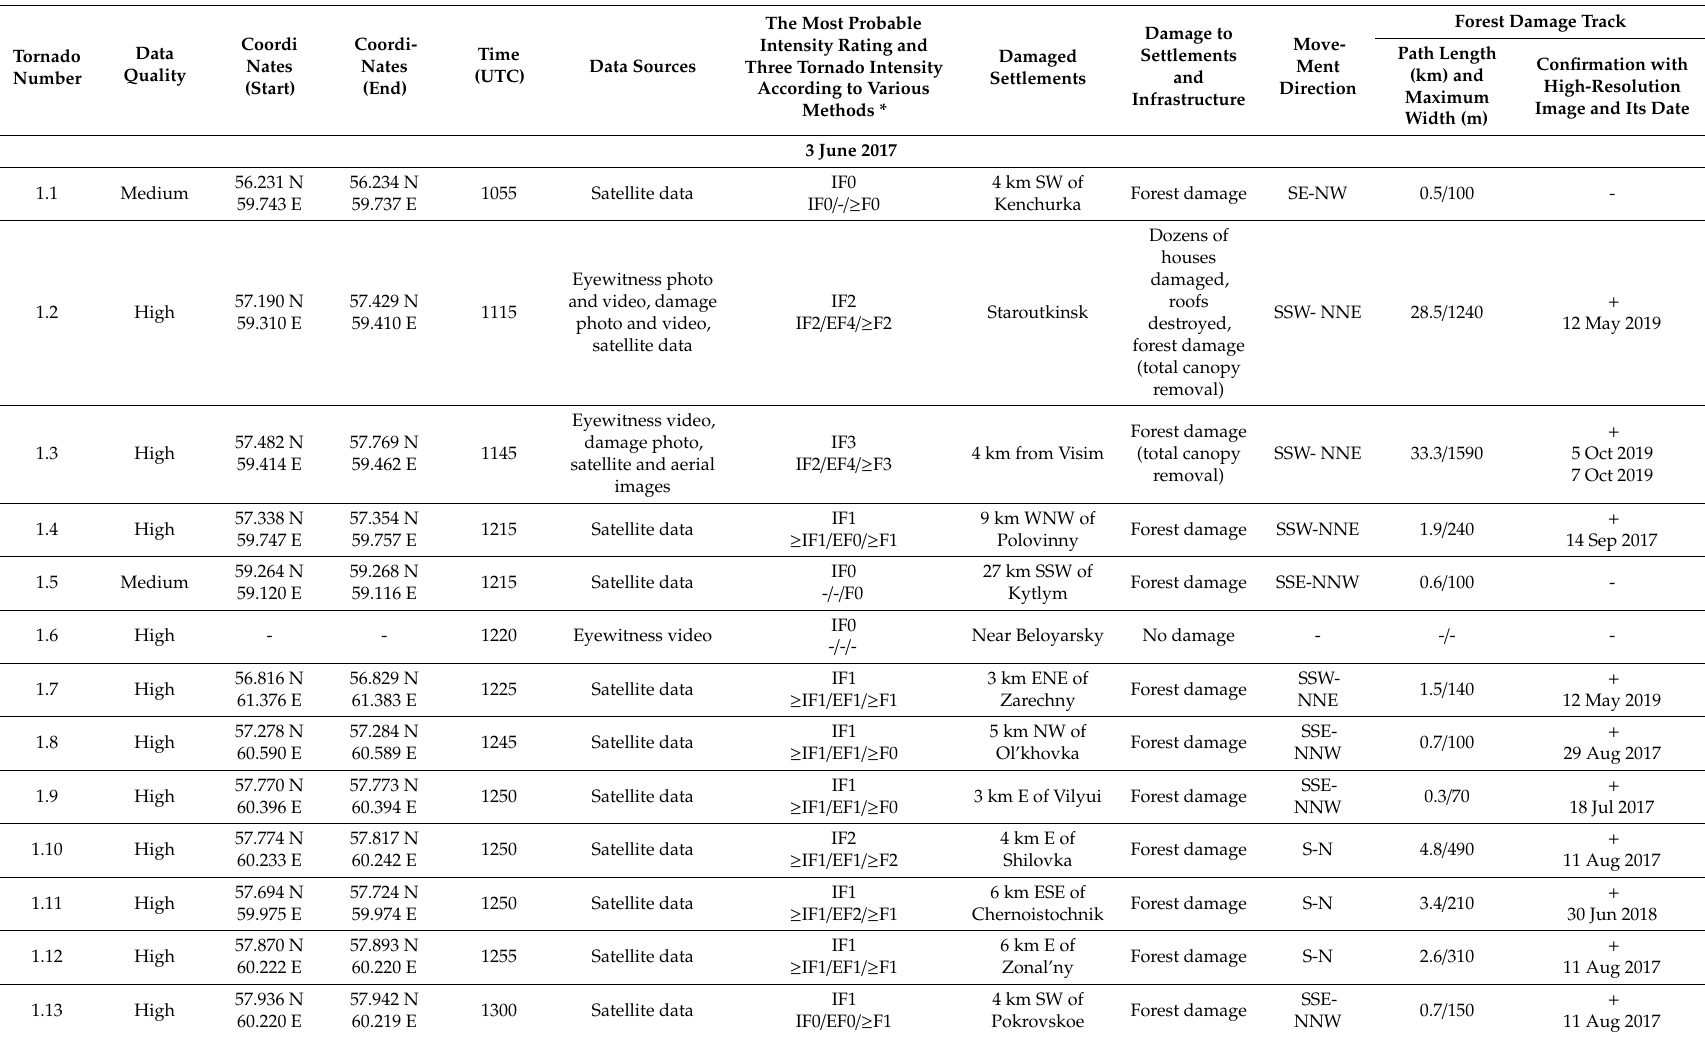
Table A2. List of tornado events that occurred on 3 June 2017 and 18 June